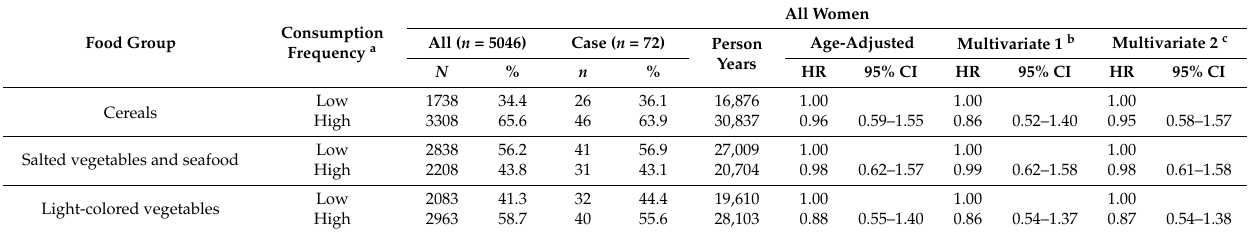
Table 2. Sixteen food groups and their associations with the risk of breast cancer in all